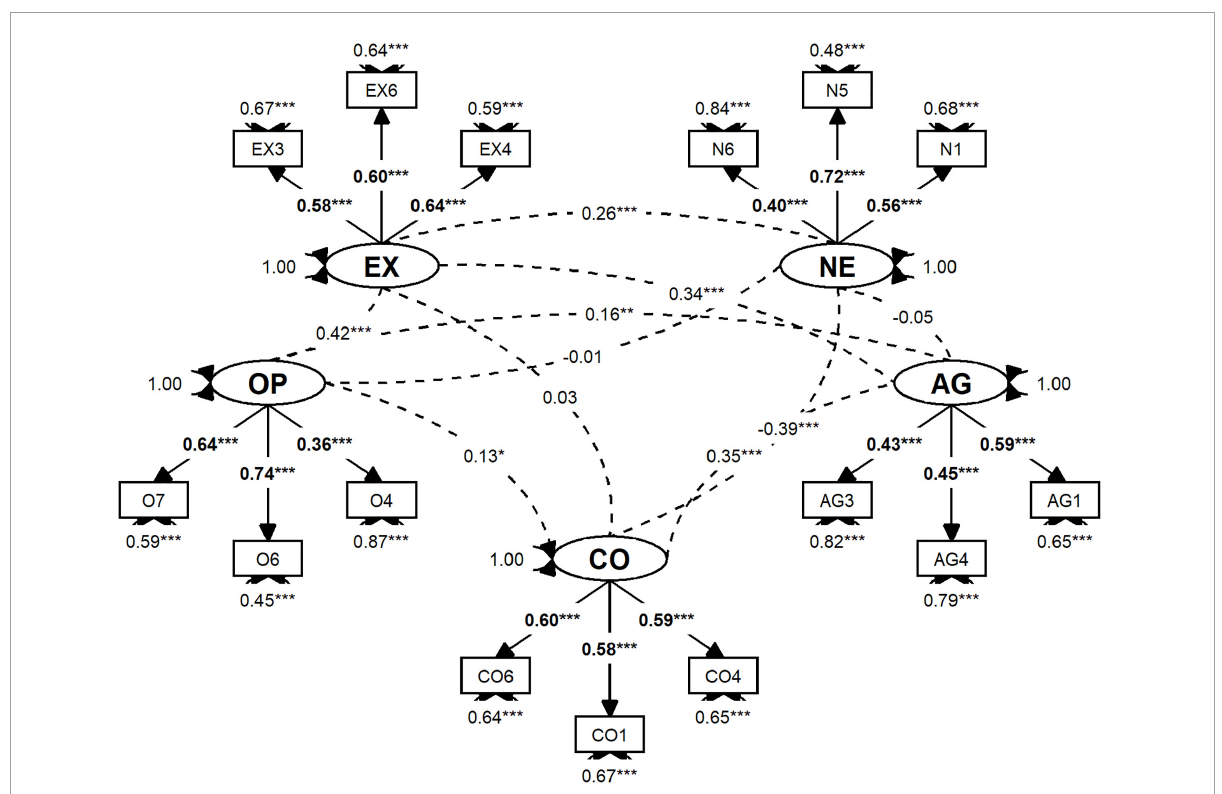
FIGURE1 The five-factor CFA model of personality based on the sample of 1500 adult